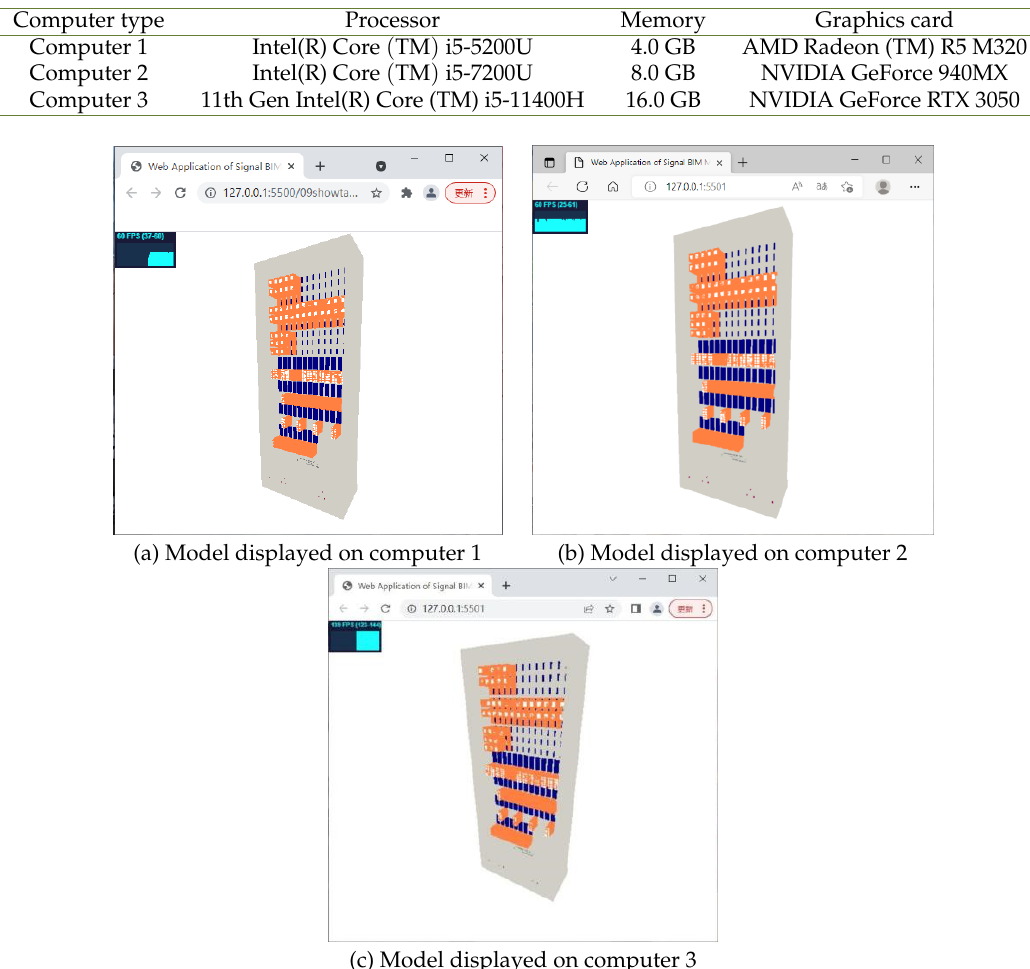
Table 9. Configuration of different computers